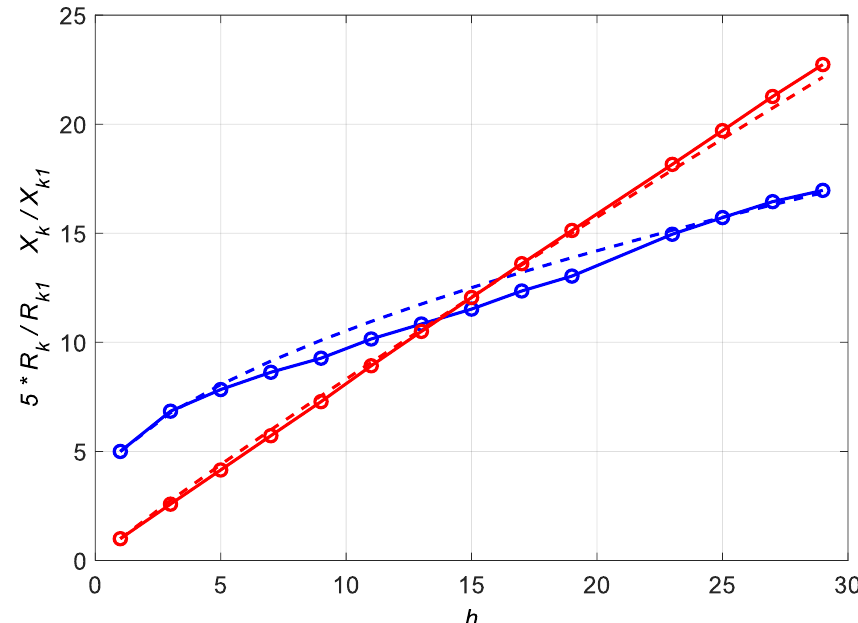
Figure 2. Measurement values of short-circuit resistance ( × 5, blue line and points) and reactance (red line) as a function of the harmonic number and their approximations (dashed lines).